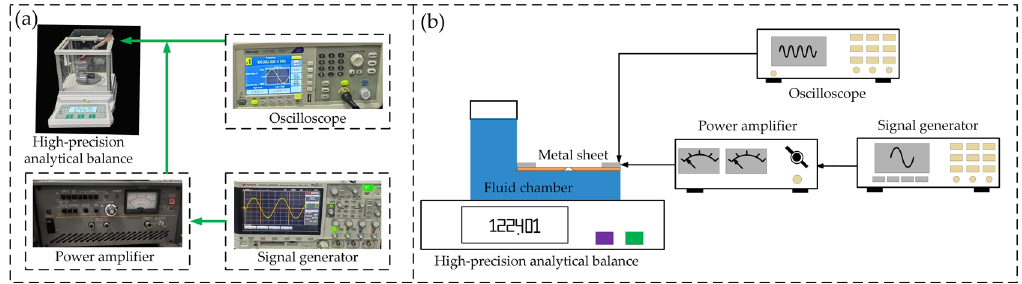
Figure 9. Atomization experiment device: ( a ) Picture of real products; ( b ) Schematic.